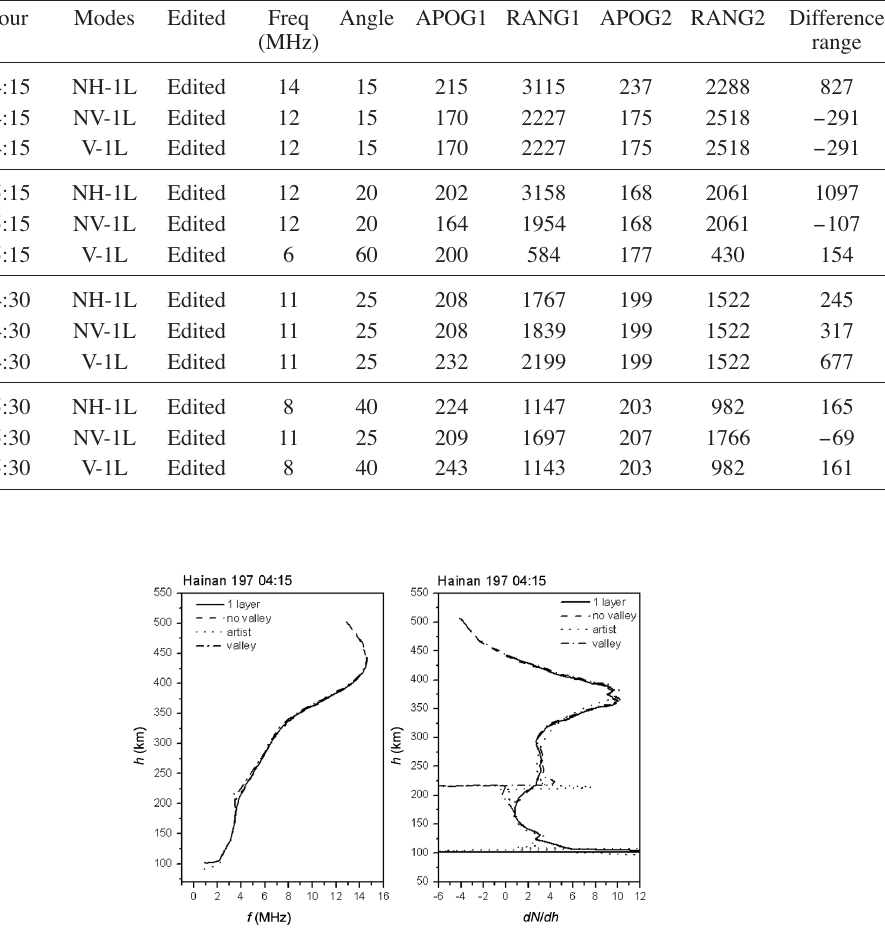
tion and can reach large values with the NHPC